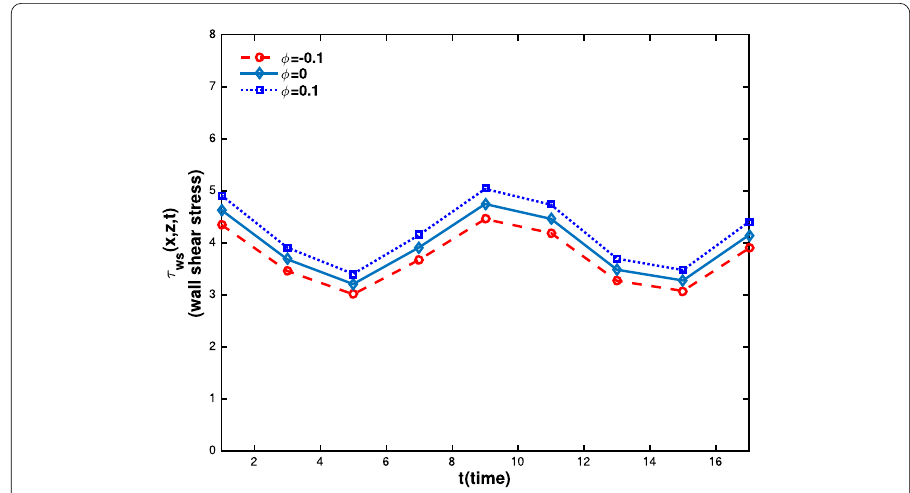
Figure 10 Wall shear stress vs time for φ = –0.1,0,0.1 at z = 28, τ y = 0.4, K = 1.6